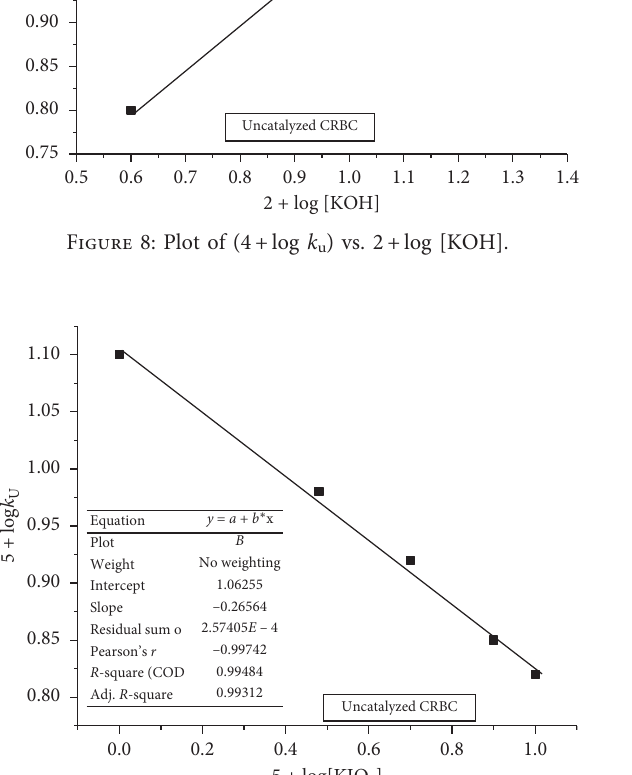
Figure 9: Plot of (5+log k u ) vs. 5+log [KIO 4 ].